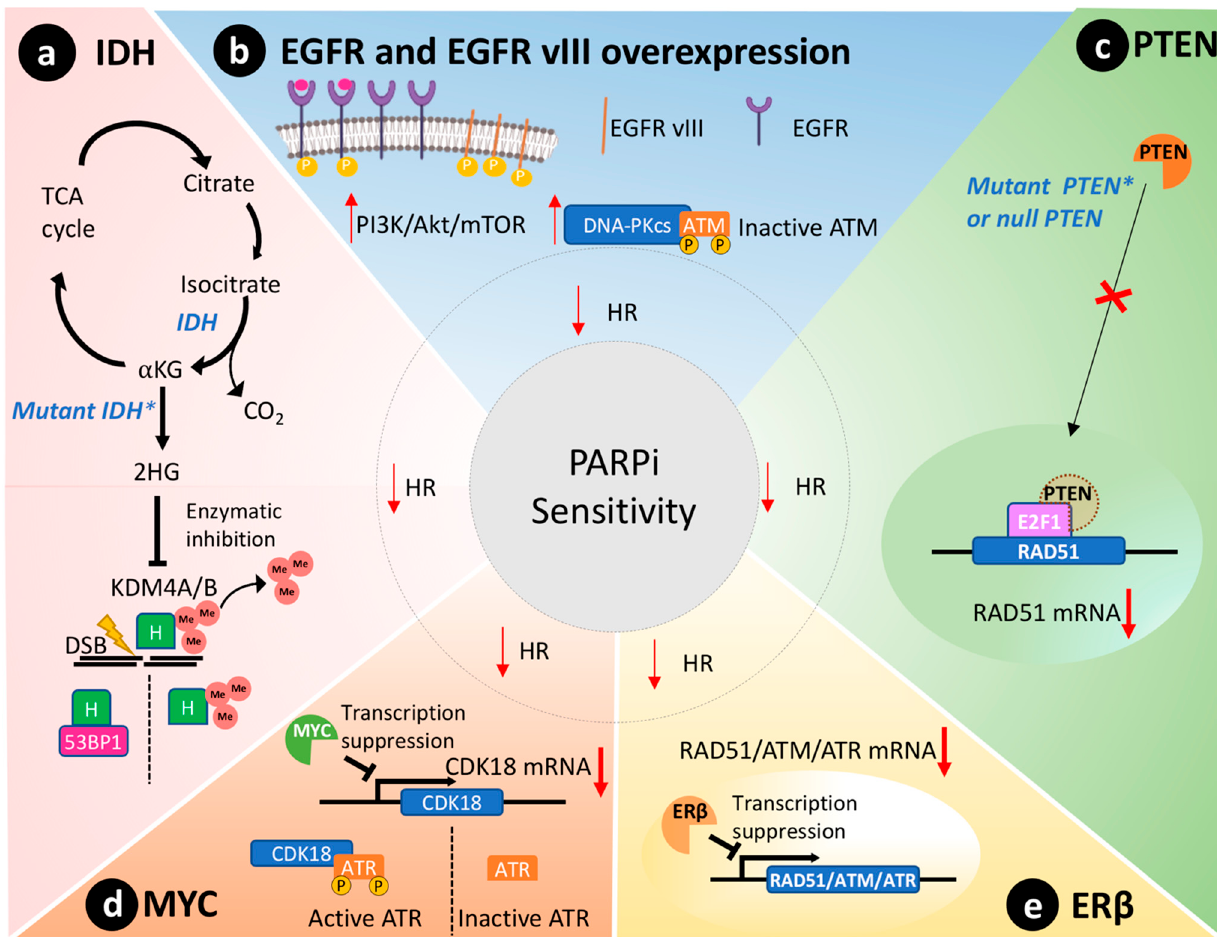
Figure 2. BRCAness phenotype in GBM that leads to impairment of the homologous recombination repair (HR) and PARPi sensitivity. ( a ) The mutated isocitrate dehydrogenase (IDH) enzyme results in the newly acquired ability to produce the oncometabolite 2-hydroxyglutarate (2HG) that inhibits lysine-specific demethylase 4A/B (KDM4A/B), which removes methyl (Me) groups from histones (H). In turn, the methylated histones will hinder the interaction of P53 binding protein 1 (53BP1) with double-strand breaks (DSB) and HR repair. ( b ) The overexpression of epidermal growth factor receptor (EGFR) or the constitutively active EGFR variant III (EGFR vIII) will lead to activation of the PI3K/Akt/mTOR pathway and consequently the activation of DNA-dependent protein kinase catalytic subunit (DNA-PKcs) that will inactivate ATM through phosphorylation. ( c ) PTEN transported to the nucleus induces the transcription of RAD51, an important component of the HR. In GBMs where PTEN is mutated or null, the transcription of RAD51 is reduced, and the HR is impaired. ( d ) MYC protooncogene directly suppresses the expression of CDK18 through interaction with its promoter that is responsible for activating the ATR through phosphorylation. ATR is an important component of HR. ( e ) ER β is a cytoplasmatic receptor that suppresses the transcription of different components of the HR, such as RAD51, ATM, and ATR. IDH: isocitrate dehydrogenase; TCA: tricarboxylic acid cycle; KG: alpha-ketoglutarate; 2HG: 2-hydroxyglutarate; KDM4A/B: lysine-specific demethylase 4A/B; H: histone; EGFR: epidermal growth factor receptor; EGFR vIII: EGFR variant III; DNA-PKcs: DNA-dependent protein kinase catalytic subunit; ATM: ataxia telangiectasia mutated; PTEN: phosphatase and tensin homolog; EF2: transcription factor 2; ATR: ataxia telangiectasia and Rad3-related; ER β : estrogen receptor beta.